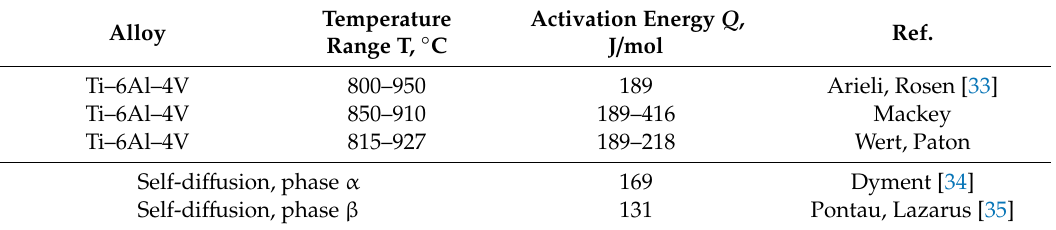
Table 3. Activation energies of self-diffusion and superplastic deformation of titanium alloys.